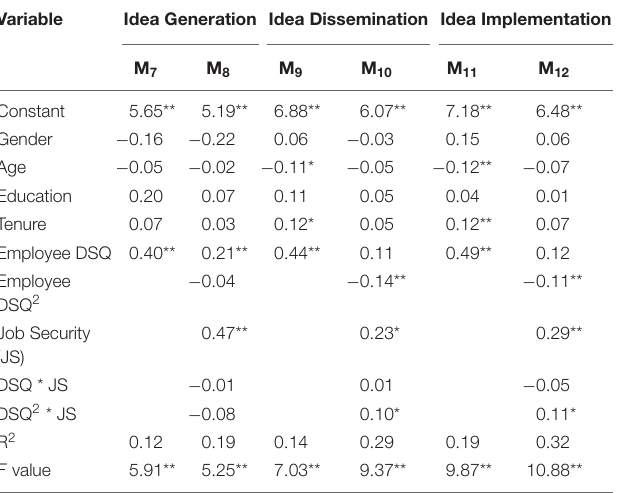
FIGURE 3 | The Inverted U-shaped relationship between dissatisfaction with the status quo (DSQ) and idea implementation. TABLE 4 | Results of hierarchical linear modeling-based regression analysis.